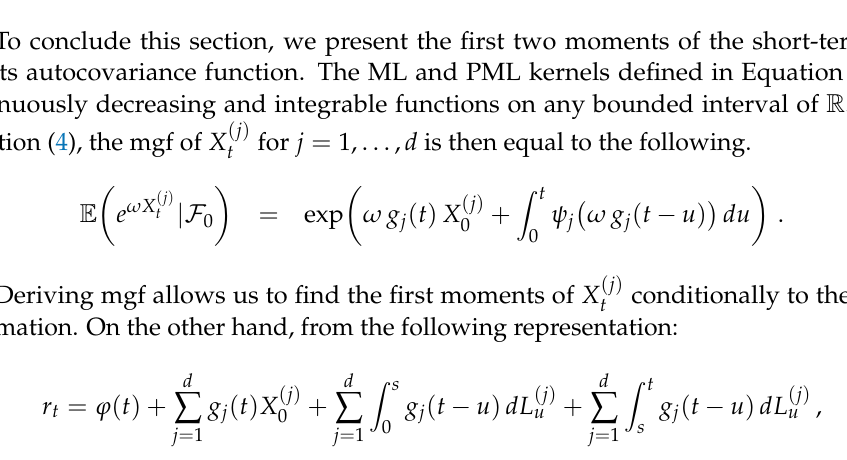
Figure 2. Upper and lower plots: Comparison of sample paths of ( r t ) and power Mittag—Leffler (PML) kernels. d = 1, β = 3, X motions with σ 1 =